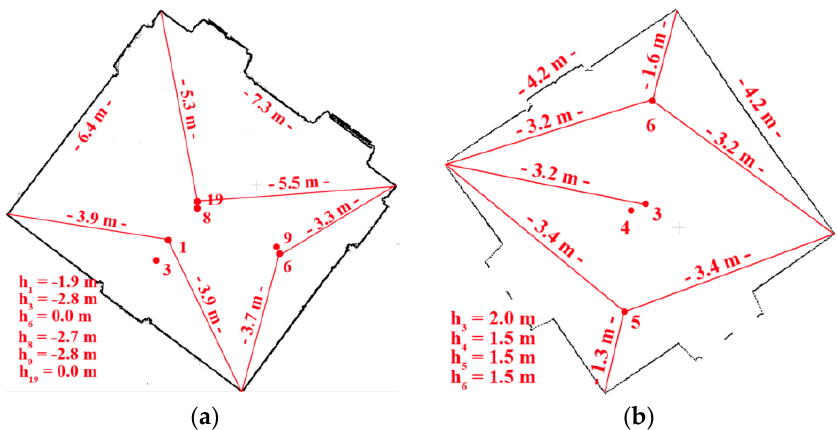
Figure 1. The point cloud in the Mercator projection of Test Site I: “The Queen’s Bedroom” with marked check points (red circles) [27].